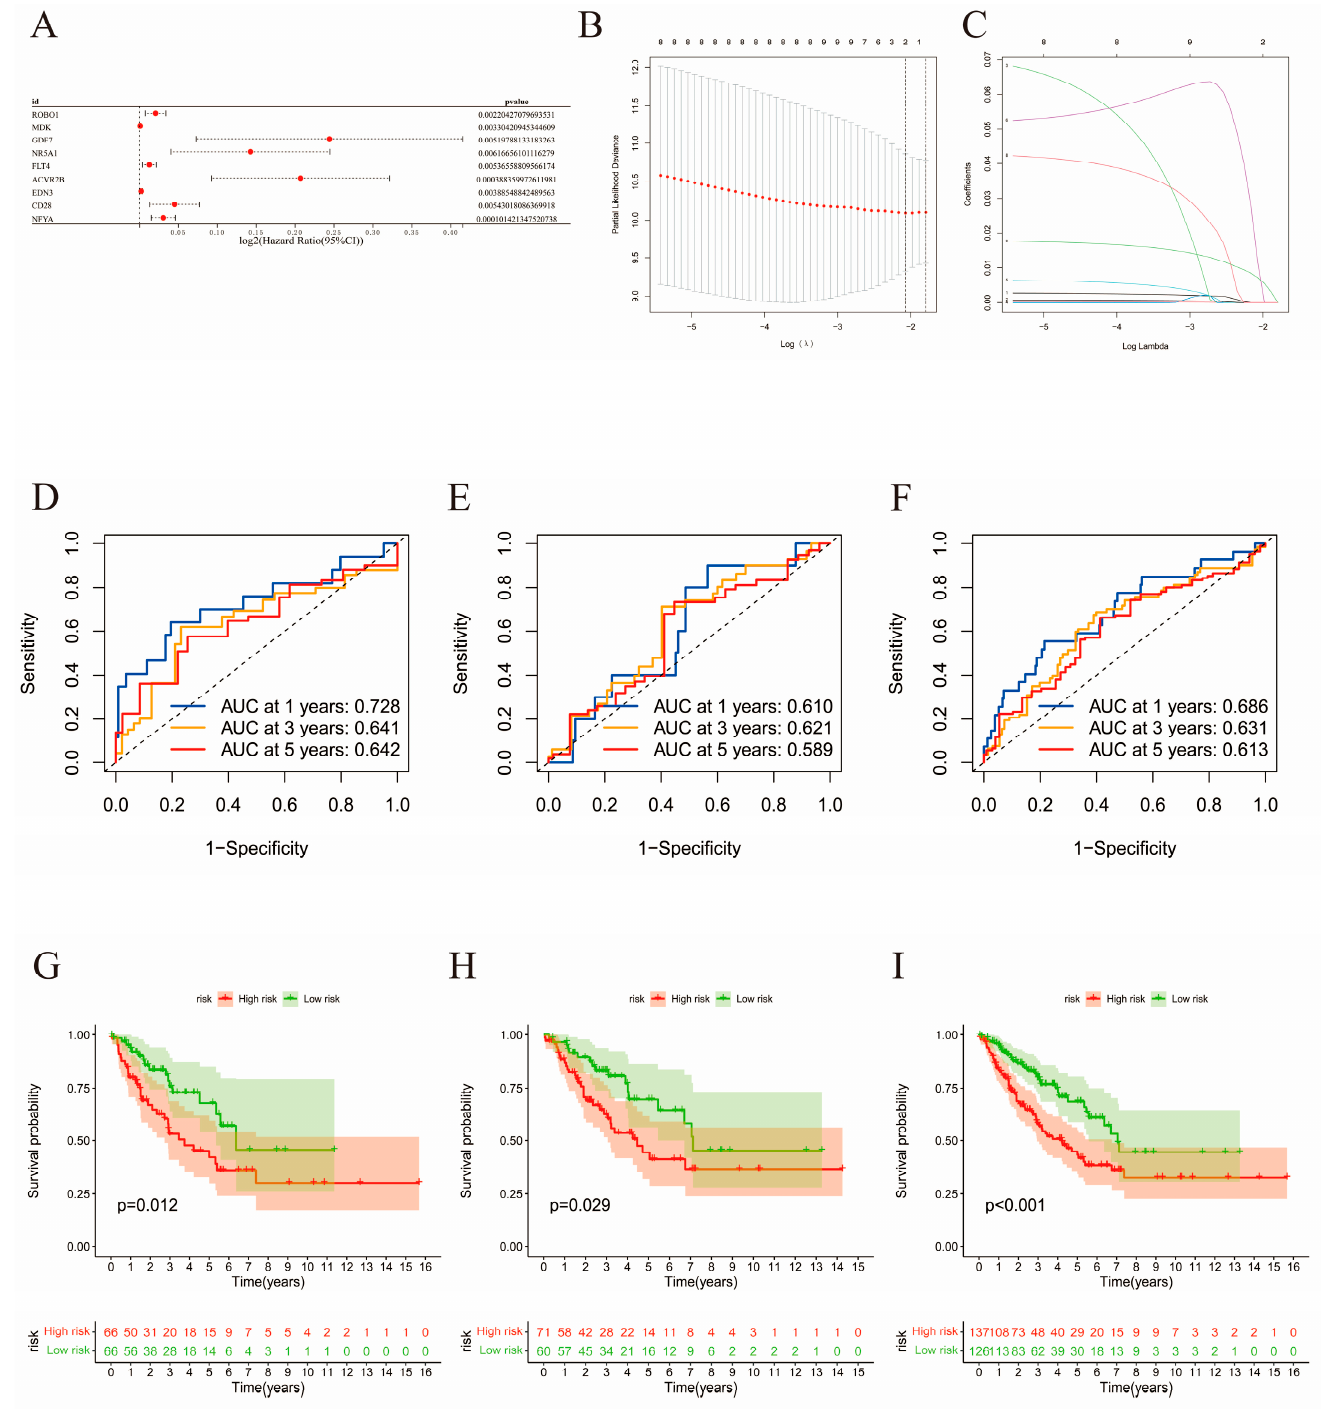
Figure 7. Construction of total risk signatures. ( A ) Forest plot of univariate analyses for nine significant immune-related DEGs of total immune infiltration with overall survival. ( B , C ) LASSO analysis to screen for the most significant candidate genes. ( D – F ) ROC curves for prognostic values of risk signature in training, validation, and the initial merged cohort, respectively. ( G – I ) K-M curves of survival analysis for training, validation, and the initial merged cohort, respectively.